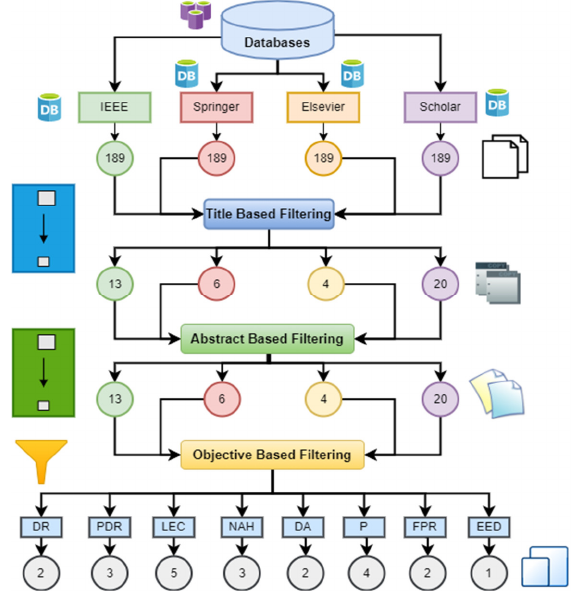
Figure 5. Screening for research articles selection in order to deduce the research objectives.